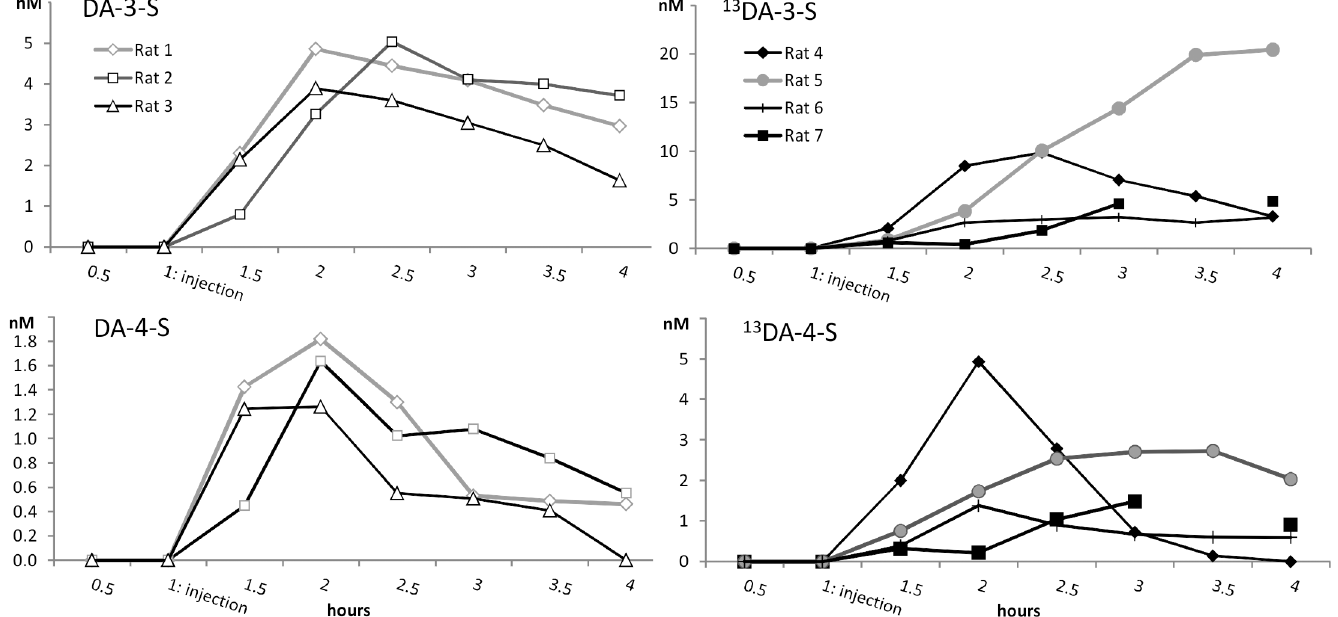
Fig 2. Concentrations of non-labeled and 13 C 6 -labelled DA-3-S and DA-4-S in rat brain microdialysates after s.c. injections.